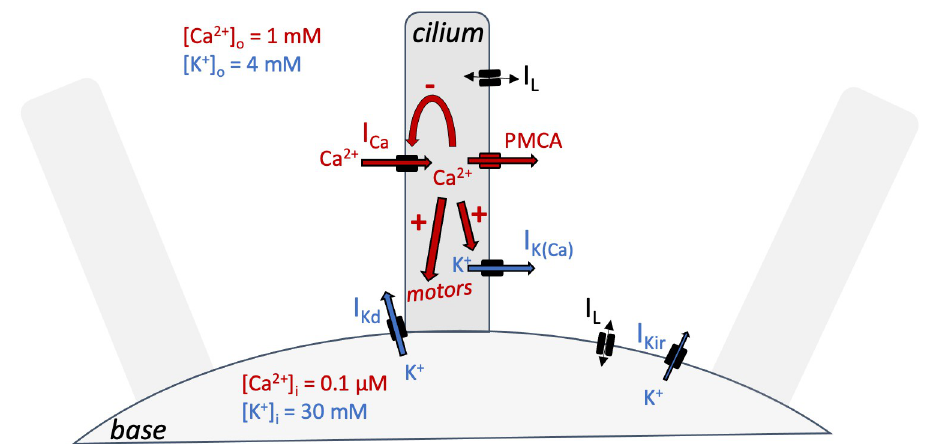
Fig 3. Summary of the model, showing a cilium attached to the base, and the movements of the two main ions, Ca 2+ (red) and K + (blue). There is more Ca 2+ outside than inside, and more K + inside than outside. Calcium enters through ciliary voltage-gated channels as a current I Ca . It then quickly inactivates these channels, forming a negative feedback loop. Calcium activates motor proteins, triggering ciliary reversal, as well as a ciliary K + channel, producing an outward K + current I K(Ca) . The motor activation results in calcium concentration [Ca 2+ ] i modulating kinematic parameters. Calcium is then expelled, in particular by plasma membrane Ca 2+ ATPases (PMCA). Depolarization opens voltage-gated K + channels in the basilar membrane, presumably near the cilium, creating a current I Kd (delayed rectifier). A linear leak current is also present. Finally, an inward rectifier current I Kir opens at very hyperpolarized voltages, which has little impact on the avoiding